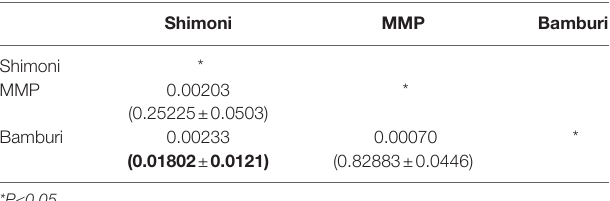
TABLE 3 | Table of pairwise F ST ( P value in brackets) showing significant genetic differentiation between samples from Shimoni and